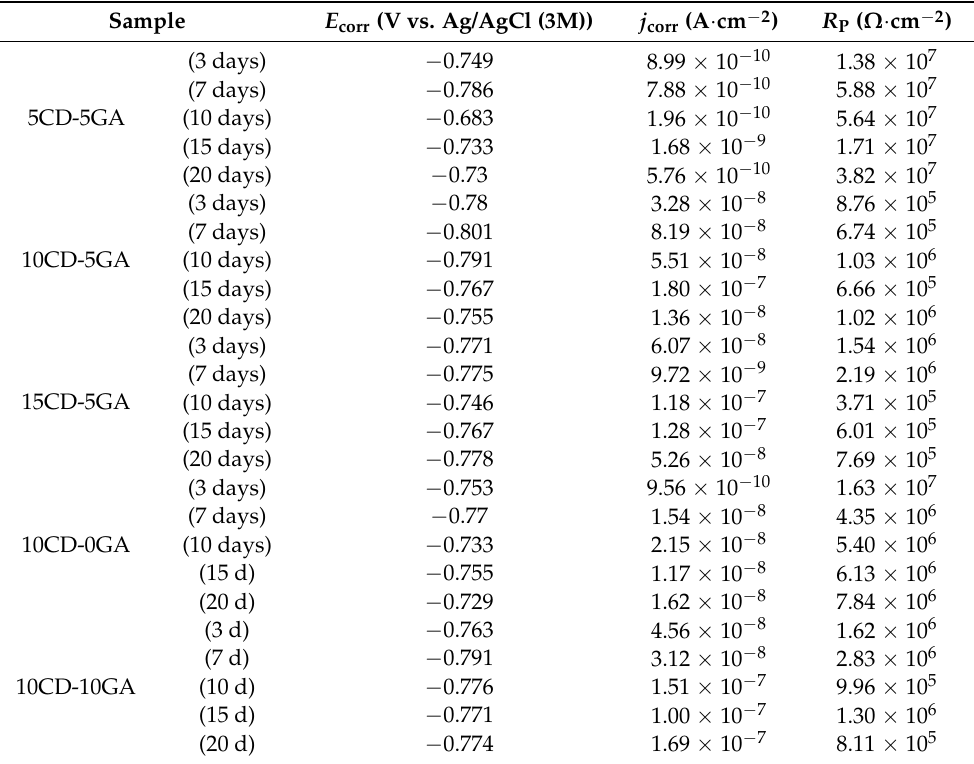
Table 2. Corrosion parameters measured from Tafel plots of each